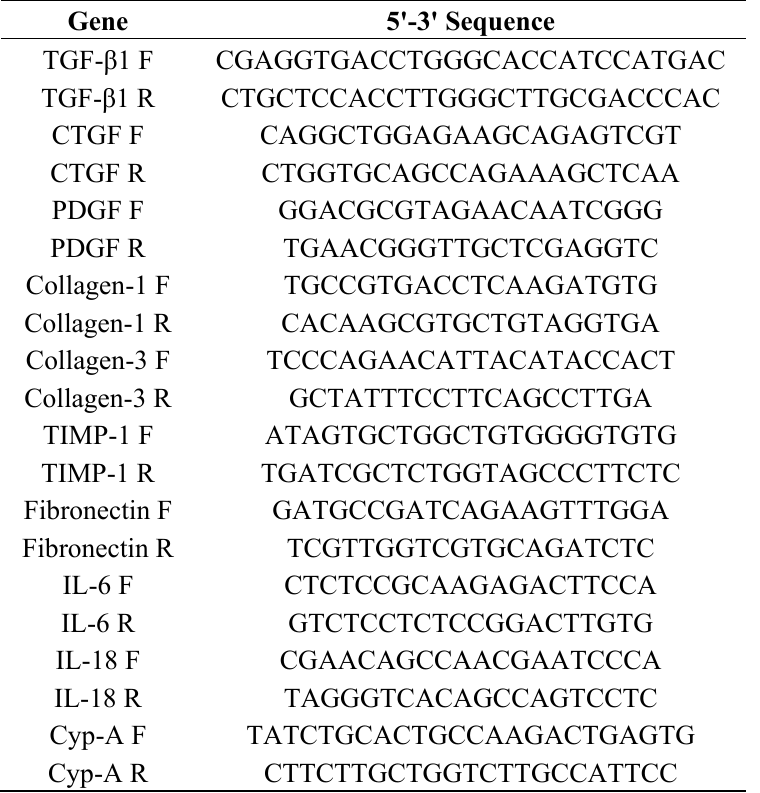
Table 1. Primers